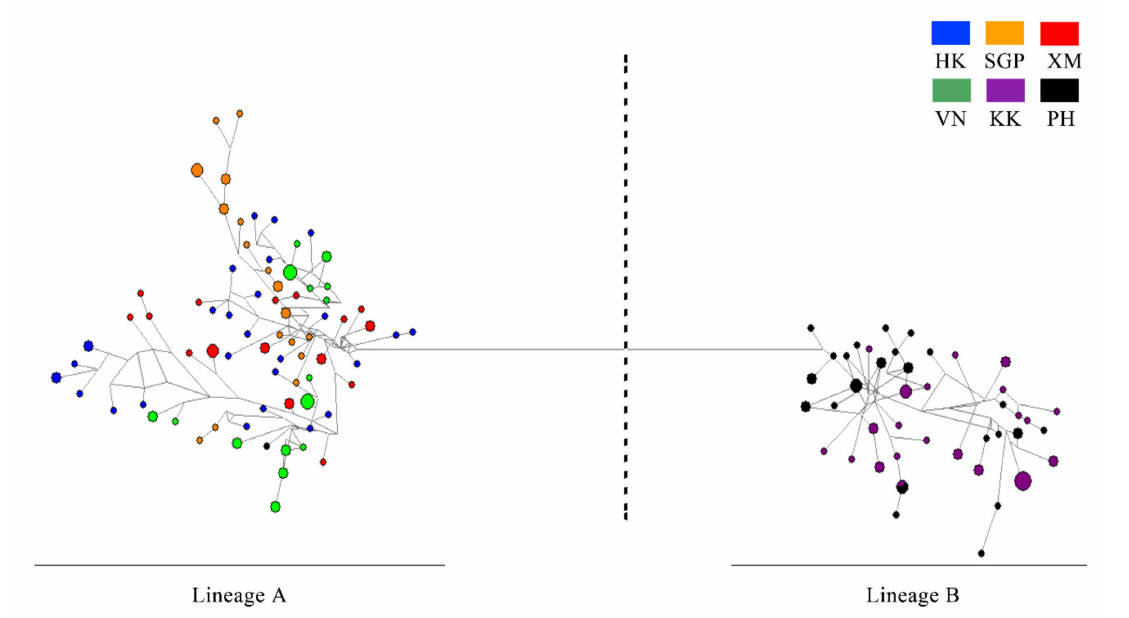
Figure 3. The haplotype network of Portunus pelagicus in all sampling